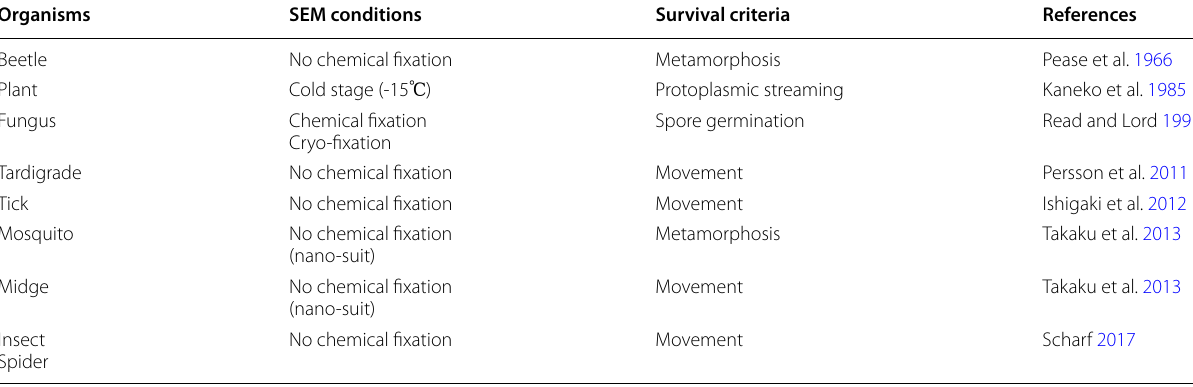
Table 1 Eukaryotes surviving scanning electron microscopy (SEM) conditions